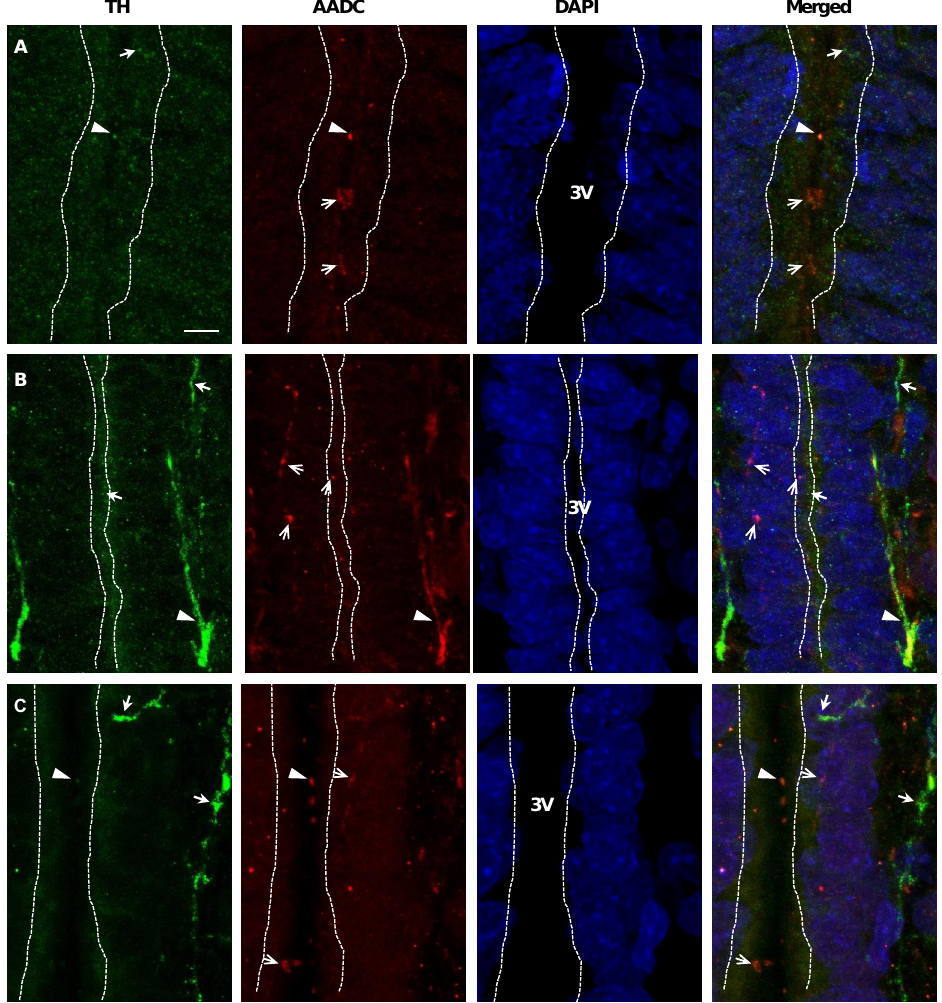
Figure 8. Confocal microscopy of the periventricular nucleus of rats on embryonic day 18 ( A ), embryonic day 21 ( B ) and postnatal day 5 ( C ): topographic relationships between the 3rd cerebral ventricle (3V, dotted line) and neurons (cell bodies and nerve fibers), immunopositive only for tyrosine hydroxylase (TH) (green, thick arrow), only for aromatic L-amino acid decarboxylase (AADC), (red, open arrow), and for both enzymes (TH + AADC, merged) (yellow, arrowhead). Fibers of all types are located in the subependymal zone, between the ependymal cells and in the 3rd ventricle. Cell nuclei are stained with DAPI (blue). Bar: 5 µm; ×63.